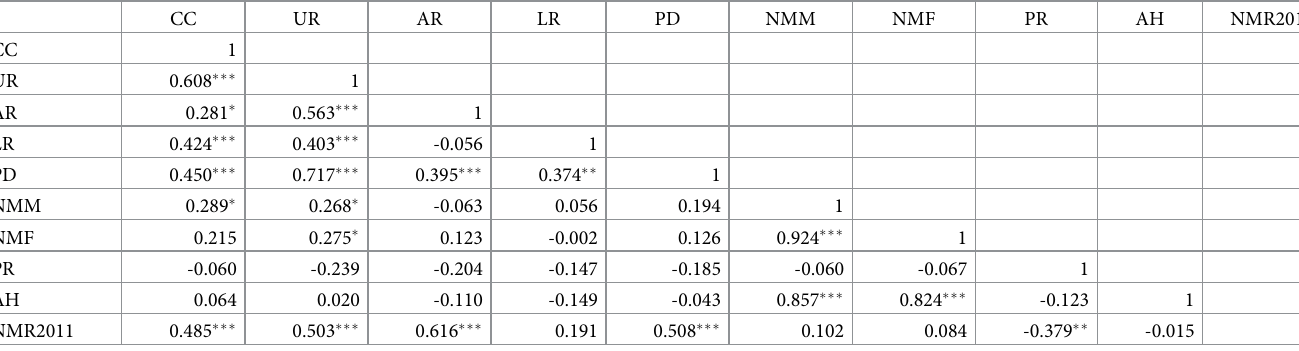
Table 3. Correlation between socioeconomic factors and internal migration in Bangladesh, 2011.